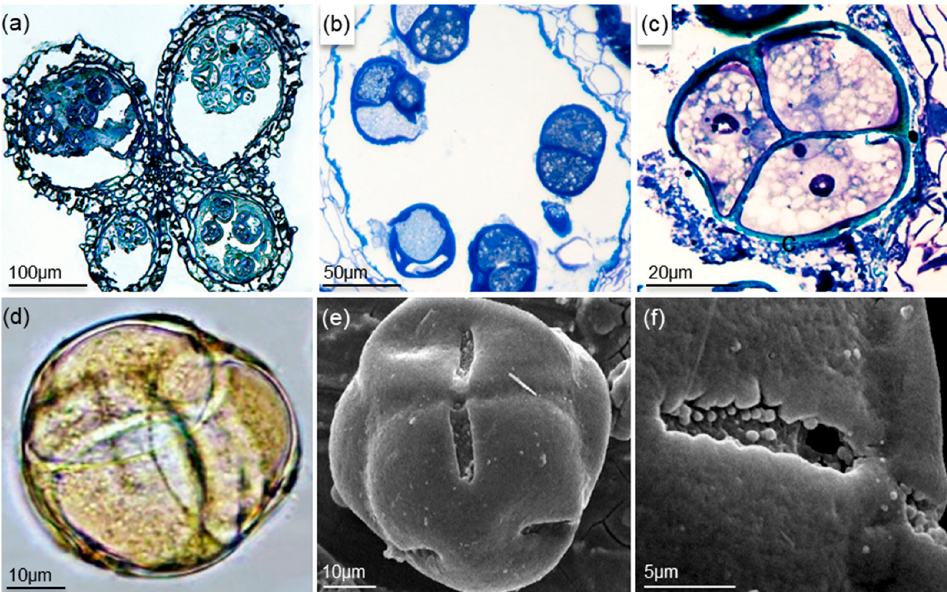
Figure 3. Anther and pollen morphology of strawberry tree: ( a ) anther cross-section stained with toluidine blue; ( b ) pollen sac with aborted pollen grains; ( c ) pollen tetrad section stained with toluidine blue showing a bi-nucleated pollen grain; ( d ) non-acetolized pollen tetrad; ( e ) pollen tetrad on SEM; ( f ) aperture and ornamentation detail of the pollen tetrad on SEM.